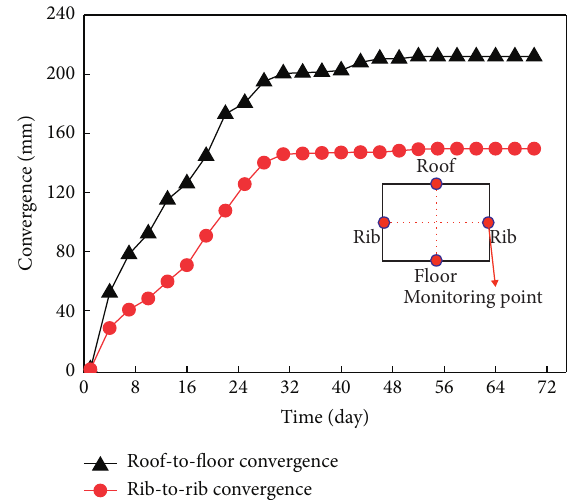
Figure 15: Monitoring results of surrounding rock deformation of